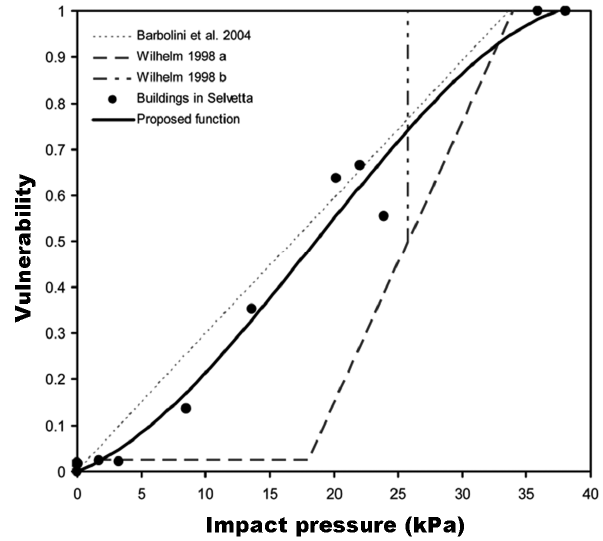
Fig. 12. Comparison of the proposed vulnerability functions pro- posed by Barbollini et al. (2004), Wilhelm (1998), and the vulnera- bility curve calculated from the Selvetta debris flow event